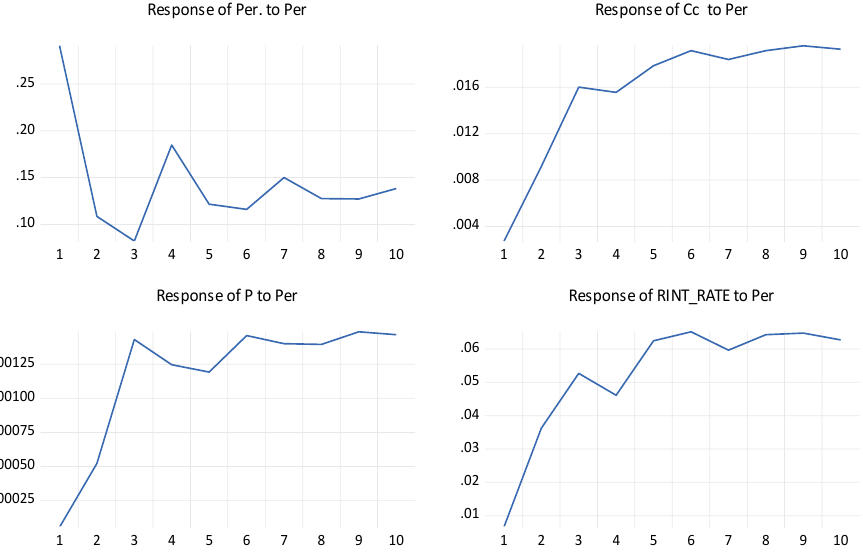
Figure 6. The response of housing permits to housing demand in Izmir, Turkey.